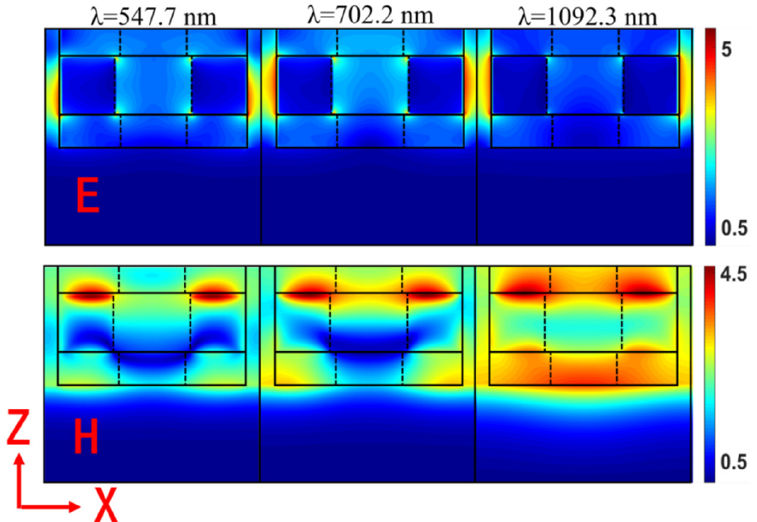
Figure 5. Electric and magnetic field distribution at three resonant wavelengths in the XOZ direc- tion.